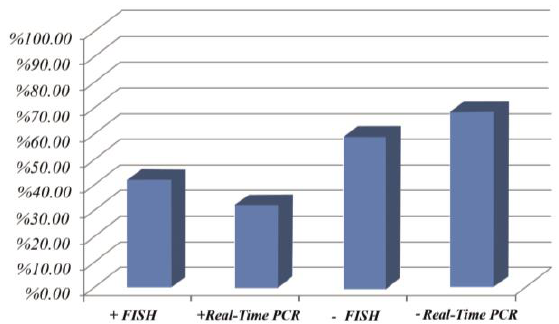
Fig 2. Results of positive /negative samples for FISH and Real-Time